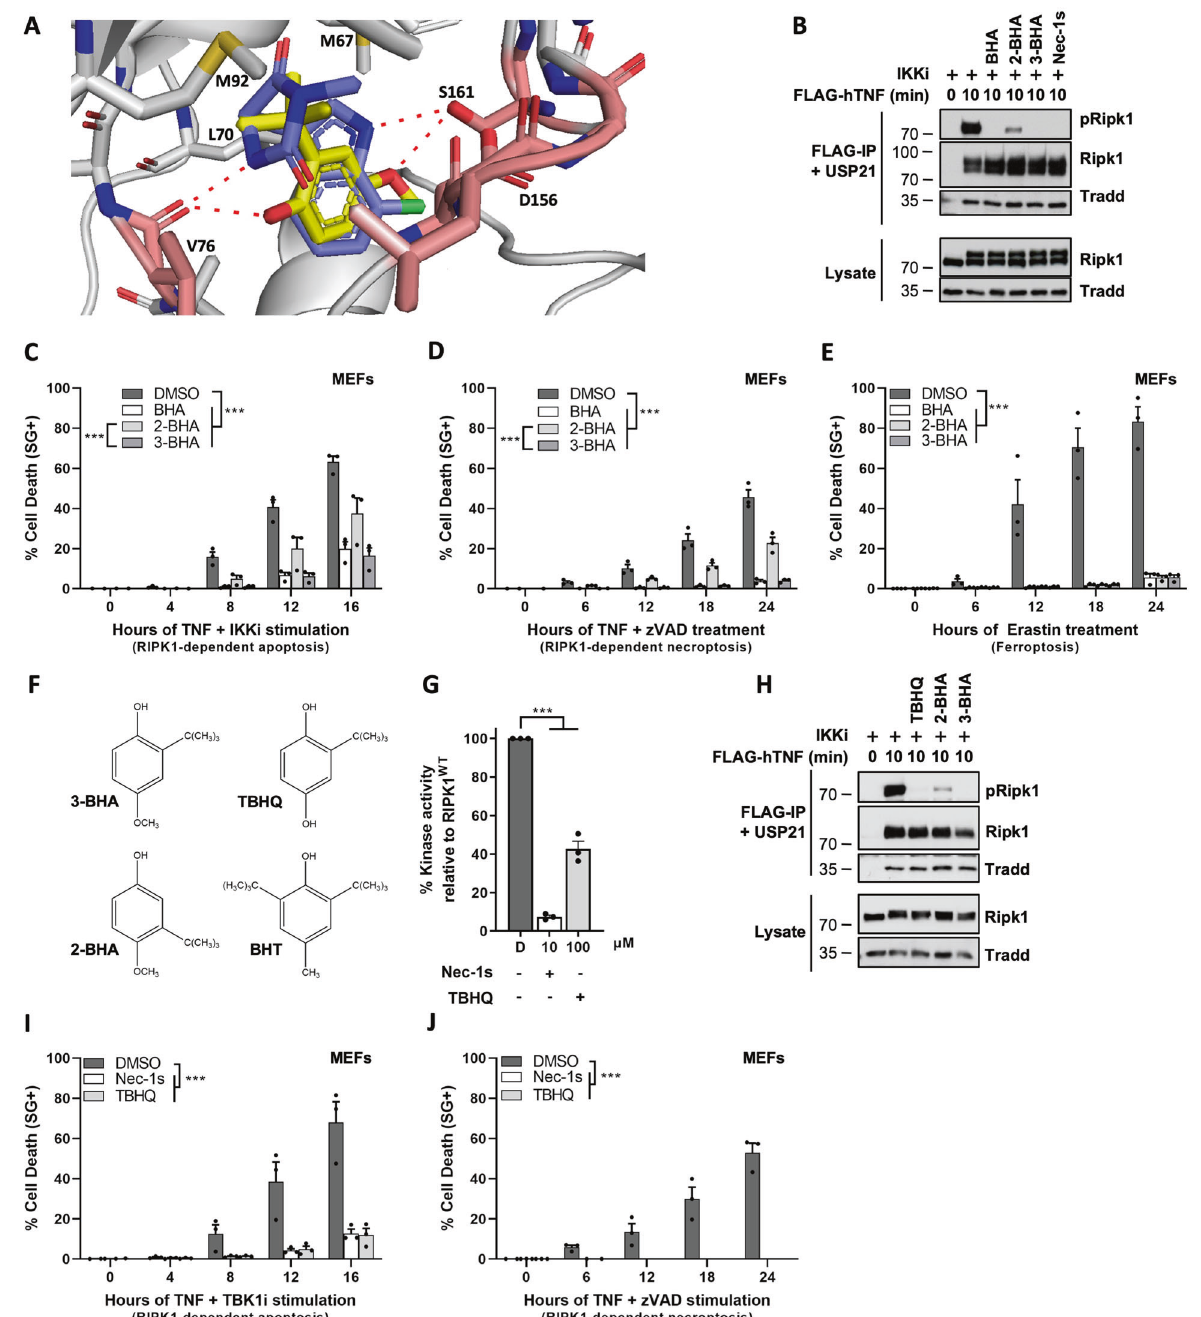
Fig. 5 3-BHA and TBHQ function as type III inhibitors for RIPK1. A Docking of Nec-1s (purple) and 3-BHA (yellow) into RIPK1 (PDB: 4ITH). Hydrogen bonds (2.7 – 3.0 Å) with residues V76 and S161 of RIPK1 are shown as red dashes. Hydrophobic residues M67, L70, and M92 of RIPK1 engaged in hydrophobic interaction are also indicated. B , H MEFs were pretreated for 30 min with indicated compounds before stimulation with 1 µg/ml FLAG-hTNF for the indicated duration. TNFR1 complex I was FLAG-immunoprecipitated and the IPs were treated with USP21 post-IP when indicated. The results are representative of at least two independent experiments. pRIPK1 refers to autophosphorylation of RIPK1 on S166/T169. C – E, I – J MEFs were pretreated for 30 min with indicated compounds (100 µM BHA, 100 µM 2-BHA, 100 µM 3-BHA, 100 µM TBHQ, 10 µM Nec-1s, 10 µM GSK8612 (TBK1i), 50 µM zVAD-fmk) before stimulation with 20 ng/ml hTNF ( C – D, I – J ) or 10 µM erastin ( E ) for the indicated duration. Cell death was measured over time by Sytox Green (SG + ) positivity, and the results are presented as mean ± SEM of three independent experiments ( n = 3). Statistical analysis on kinetic cell death assays with more than one timepoint is detailed in the Methods section. F Molecular structure models are presented for 2-, 3-BHA, BHT, and THBQ. G Kinase activity was quantitatively measured by ATP consumption using the ADP-Glo kinase assay, compounds were used at indicated concentrations. D is short for DMSO. Results are presented as a percentage relative to the activity of the kinase in absence of inhibitor and are the mean ± SEM of three independent kinase assays ( n = 3). Statistical signi fi cance was determined via ordinary one-way ANOVA followed by a Tukey post hoc test. Signi fi cance between samples is indicated in the fi gures as follows: * P < 0.05; ** P < 0.01; *** P < 0.001; NS, not signi fi